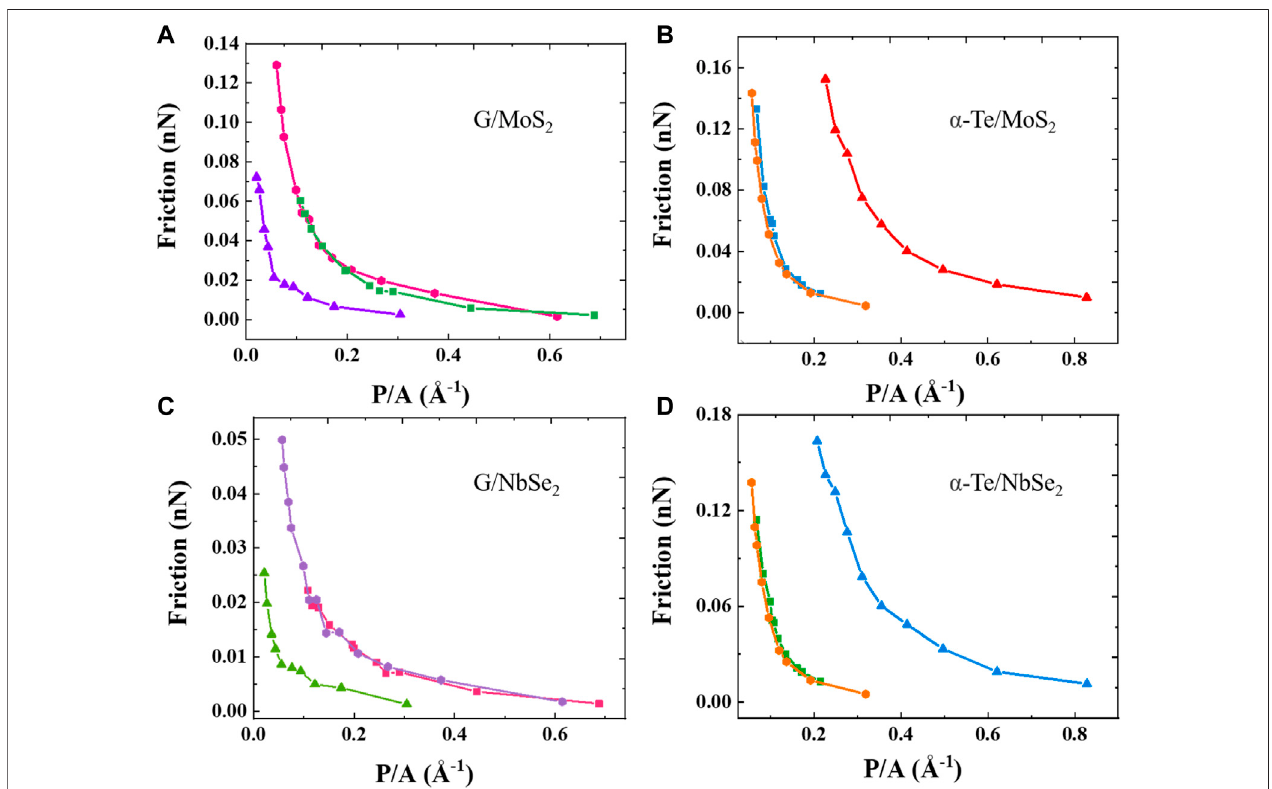
FIGURE7| Frictionforceasafunctionofperimeter/area. (A) graphene/MoS 2 ; (B) α -Te/MoS 2 ; (C) graphene/NbSe 2 ; (D) α -Te/NbSe 2 .Theshapeofthedatapoints represents the shape of the slider in the MD simulation, which are rectangular, triangular, and hexagonal.